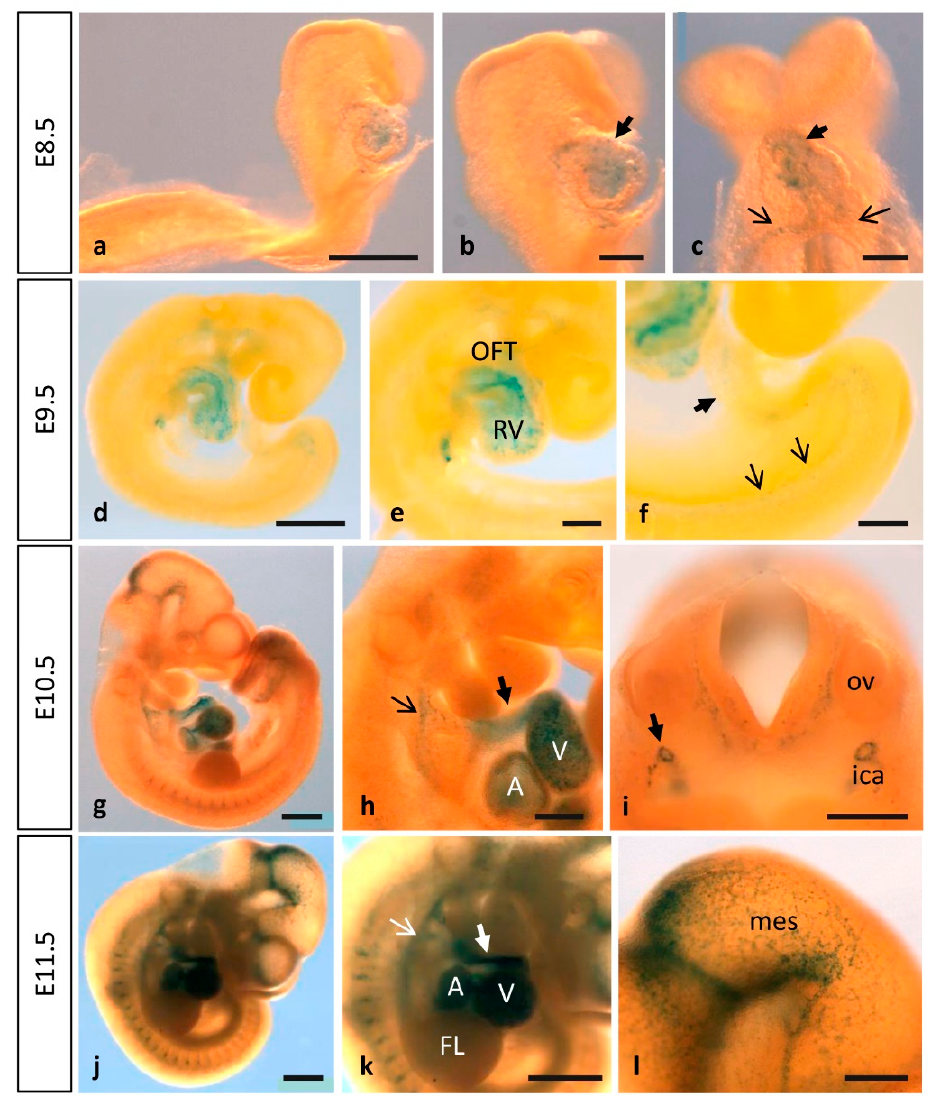
Figure 1. MT1-MMP is expressed in the early mouse embryo. Whole-mount β -gal staining in Mt1- mmp LacZ/+ embryos from E8.5 to E11.5. Staining is observed in the endocardium of the developing heart tube ( a – c ) as early as E8.5 embryonic stage. At later stages of development, this expression persists and the strongest labeling is observed in the atrium, the ventricle, the cardiac outflow tract (black and white thick arrows in ( h , k )), the aortic arch arteries (black and white thin arrows in ( h , k )) and the dorsal aorta at E9.5 ( d – f ), E10.5 ( g – i ) and E11.5 ( j – l ). Expression in the central nervous system was first detected by E10.5 ( g ) and E11.5 ( j ) in the caudal midbrain and the rostral rhombencephalon ( l ). Furthermore, β -gal positive cells were detected in the perineural vascular plexus and the first blood vessels entering the brain ( i , l ). Somites also show β -gal positive cells at these embryonic stages ( g , j , k ). Abbreviations: A, atrium; FL, forelimb; ica, internal carotid artery; mes, mesencephalon; OFT, outflow tract; ov, otic vesicle; RV, right ventricle; V, ventricle. Scale bars: 1 mm ( g , j , k ), 500 µ m ( a , d , h , i , l ), 200 µ m ( b , c , e , f ).